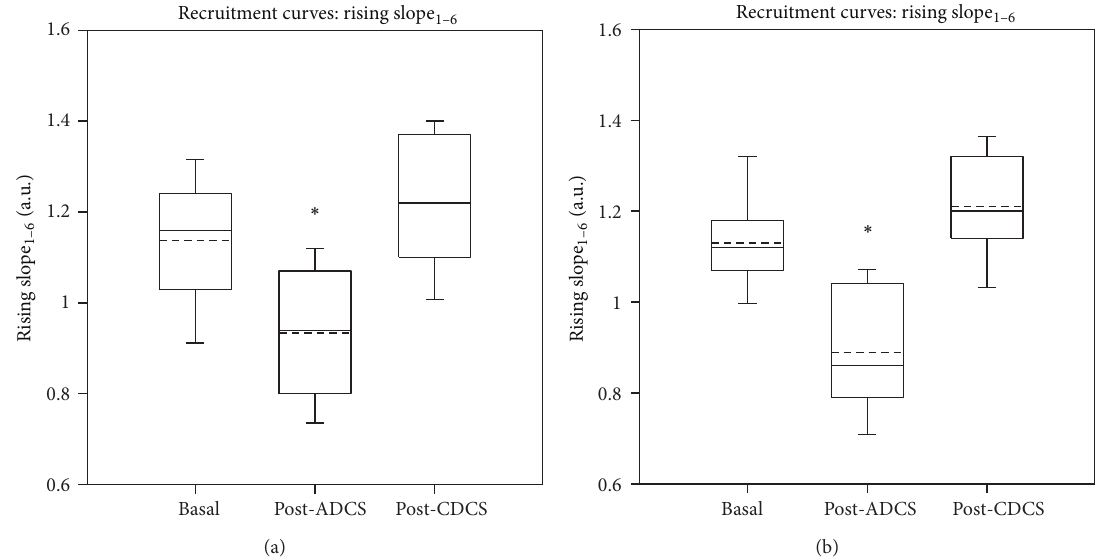
Figure 2: Box and whisker plots showing the effects of direct current stimulation applied over left cerebellar hemisphere on the slope between ) of the recruitment curve for left gastrocnemius muscle (a) and for left tibialis anterior muscle (b). the first and the sixth points ( slope 1 – 6 Basal: values in basal condition; post-ADCS: values obtained after application of anodal direct current stimulation over the dura; post-CDCS: values obtained after application of cathodal direct current stimulation over the dura. Medians (continuous lines) and means (dashed lines) are illustrated, as well as outliers (corresponding to the 5th and 95th percentiles). Values at baseline and values post-CDCS are significantly higher as compared to the values obtained post-ADCS. ∗ 𝑃 < 0.05 ( 𝑛 = 13 rats).